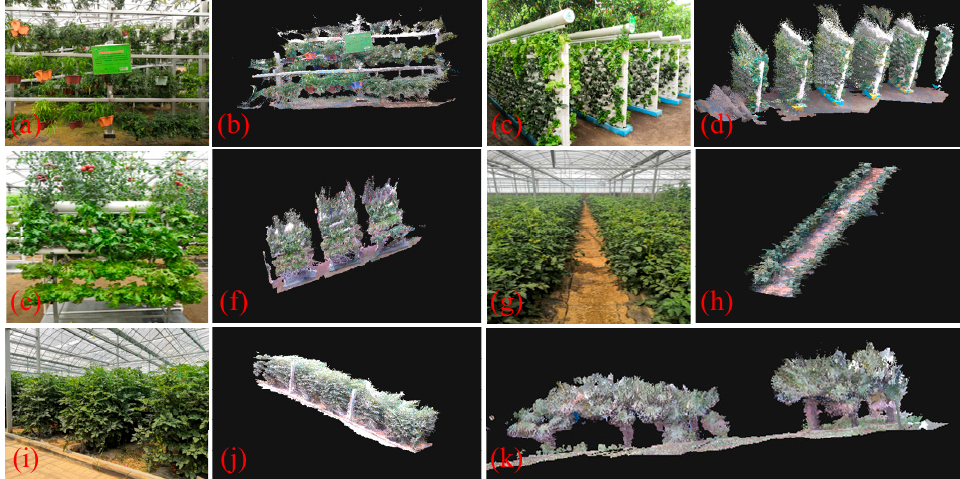
Figure 9. The reconstructed dense 3D point cloud maps. ( a , b ) The scene and dense 3D map of the orbital cultivation site ( c , d ) The scene and dense 3D map of the wall cultivation site ( e , f ) The scene and dense 3D map of the stereoscopic cultivation site ( g , h ) The scene and dense 3D map of a crop inter-row ( I , j ) The scene and dense 3D map of the periphery of crop rows ( k ) The dense 3D map of an outdoor forest.